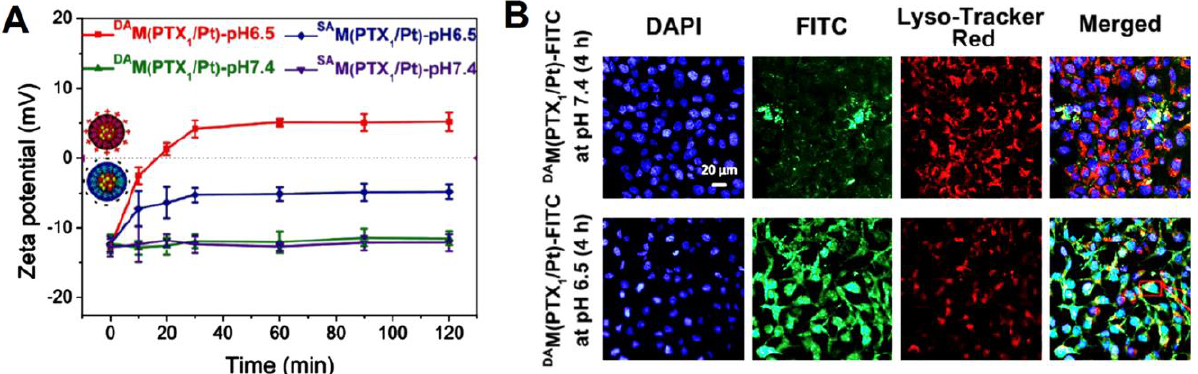
Figure 6. ( A ) Zeta potential conversion of DA and SA-containing micelles through pH variations. ( B ) CLSM images Skov-3 incubated with FITC-conjugated micelles in pH 7.4 and 6.5. Reproduced from Liao et al. [140], with permission from the Royal Society of Chemistry, Great Britain.